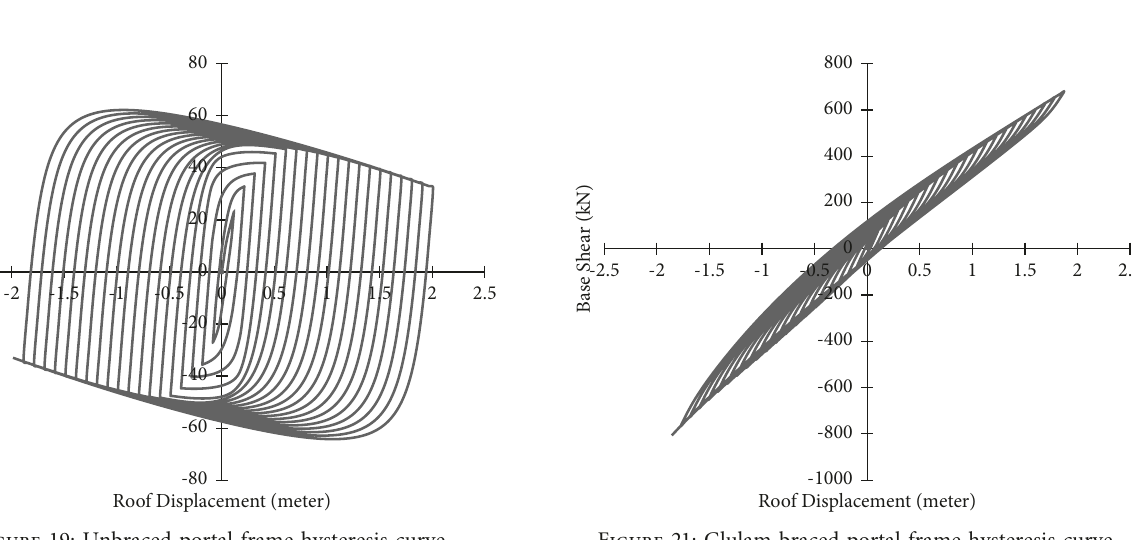
Figure 19: Unbraced portal frame hysteresis curve.